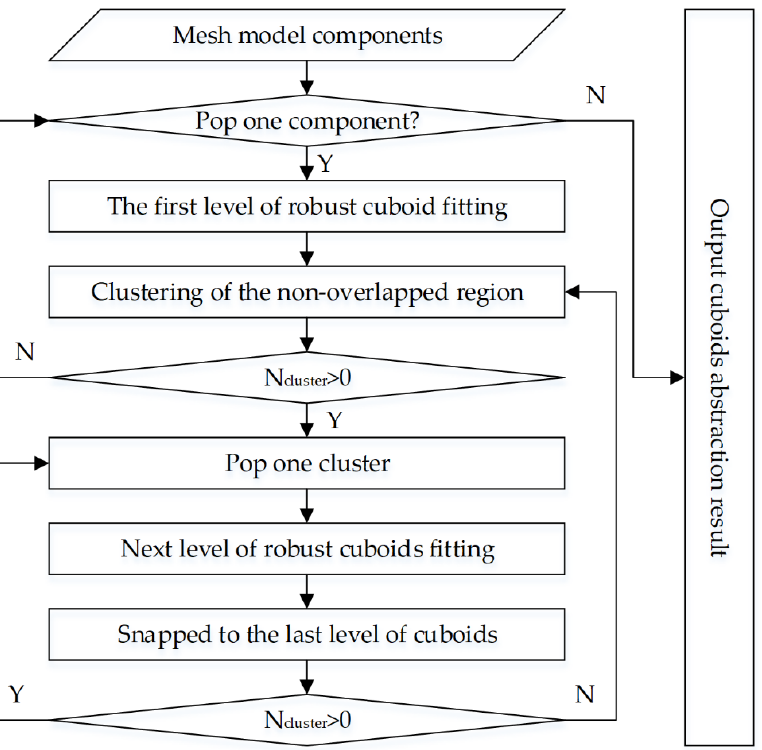
Figure 4. The workflow of the cuboid abstraction processing.